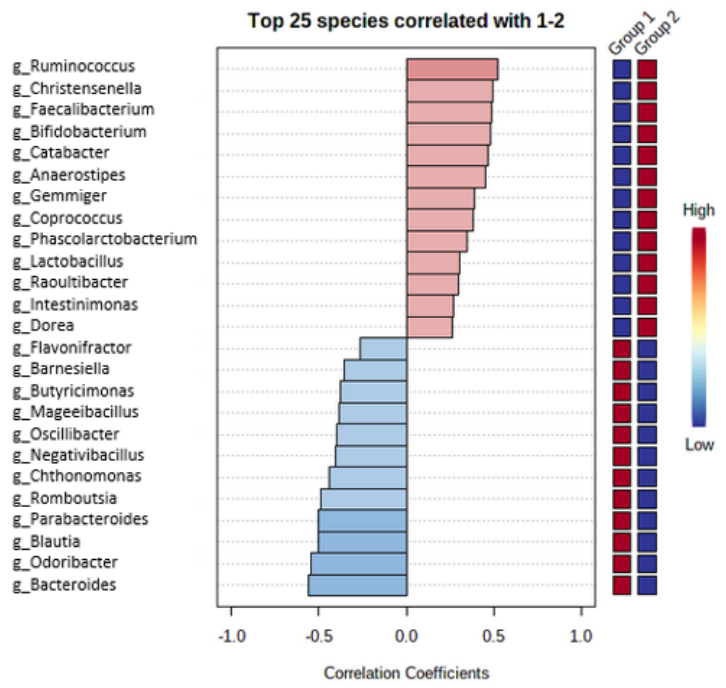
Figure 1. Differences in oral microbiota between group 1 vs. group 2.